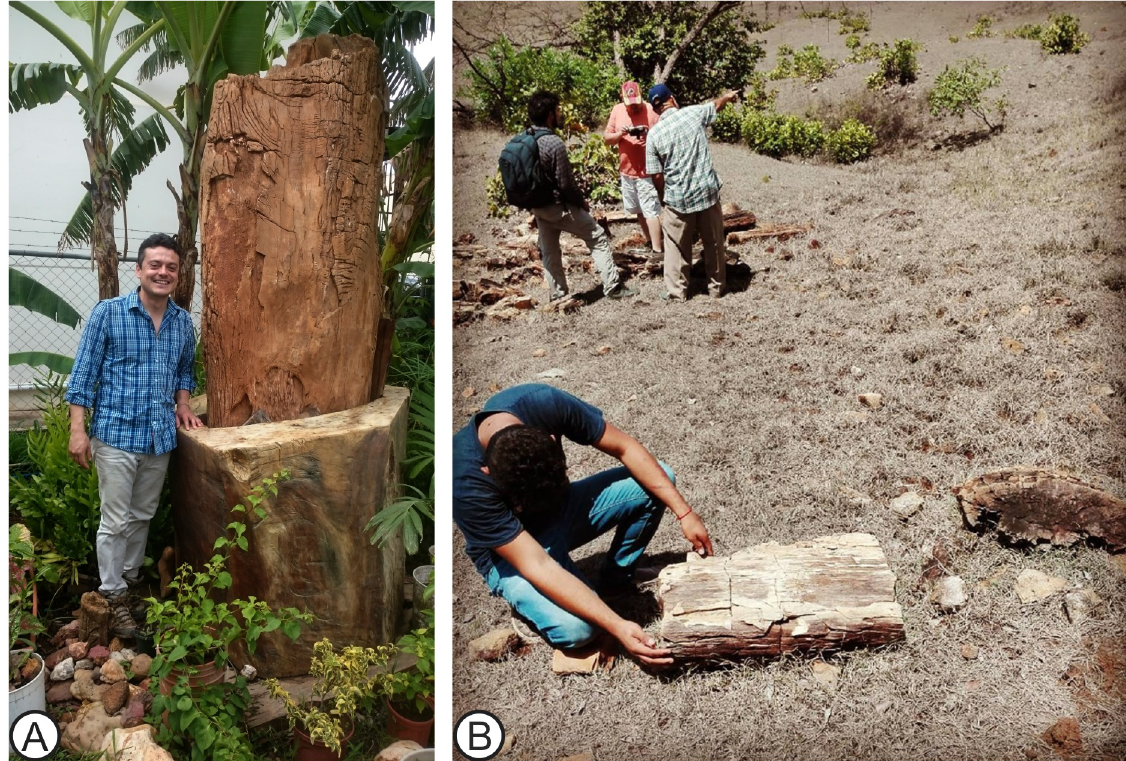
Fig 1. MUPAN-STRI 44071 and context of the field area. (A) Image of Anacardium gassonii taken in the field (B) Gullies in Los Boquerones farm in Veraguas, where several specimens were collected, including MUPAN-STRI 44051.